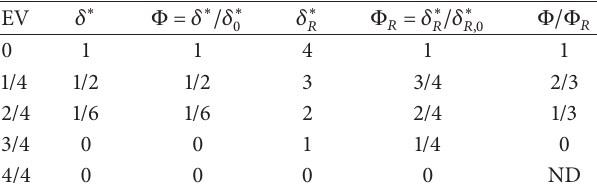
Table 1: Average diffusion coefficients of the model ( 𝛿 ∗ ) and reference model ( 𝛿 ∗ 𝑅 ) shown in Figure 2(a). EV: excluded volume; ND: not defined.